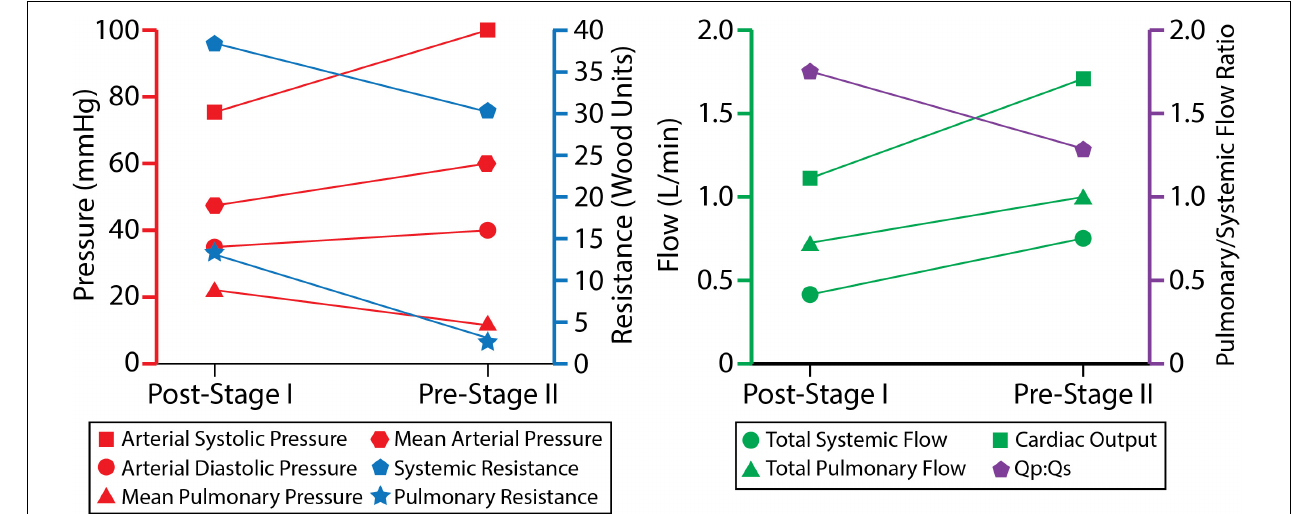
FIGURE 10 | The evolution of hemodynamic indices from ∼ 7 days of age at post-S1 to ∼ 5 months of age at